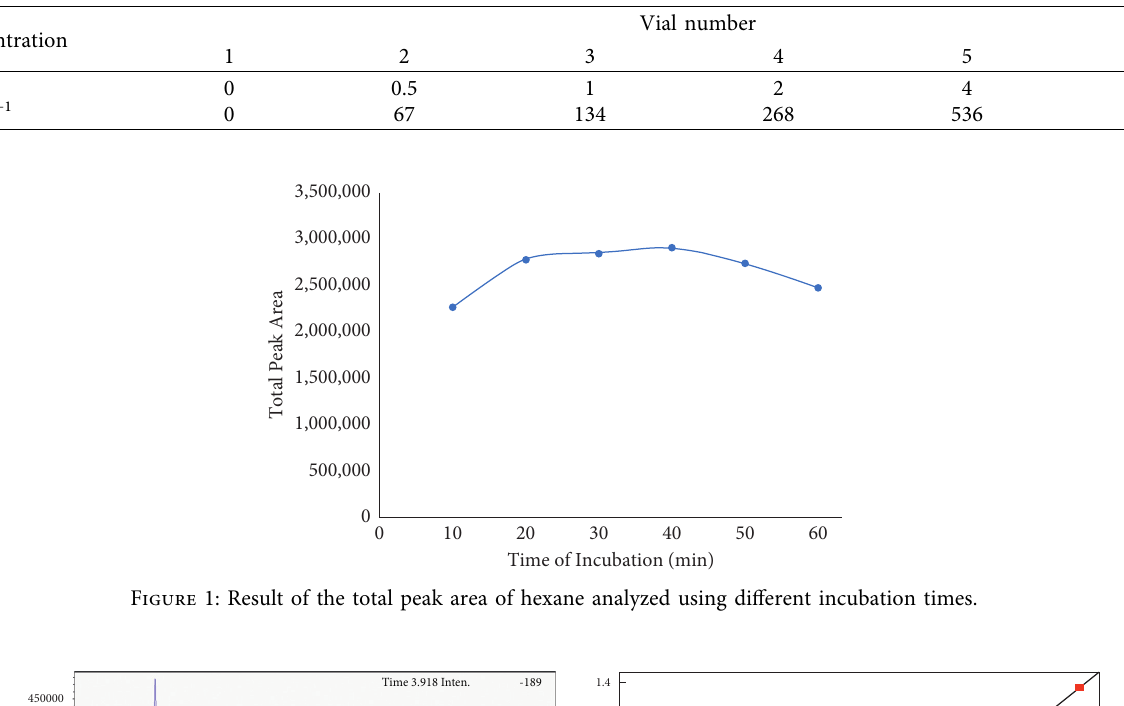
Table 1: Amount of technical hexane added in five gram of oil.